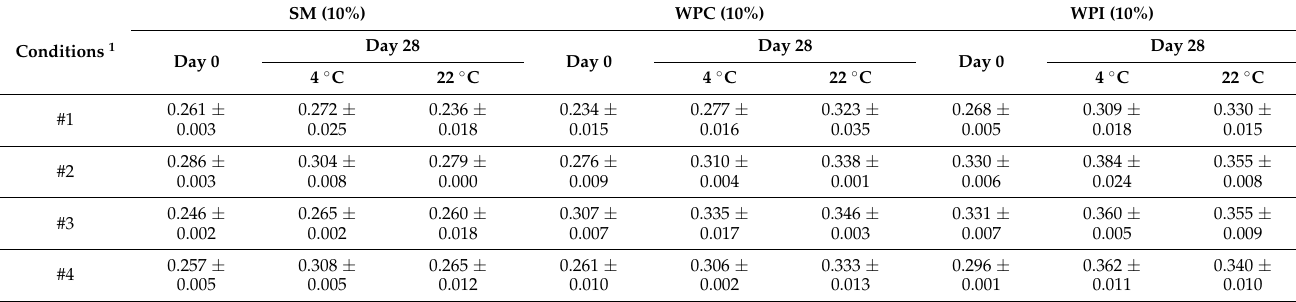
Table 2. Water activity measured for each protective matrix and condition tested, immediately after processing and upon 28 days of storage at 4 and 22 ◦ C, under controlled humidity. The values correspond to the average of two independent replicates ± standard deviation. For further information regarding the settings of conditions #1 to #4, check Table 3 in Section 3.2 of Material and